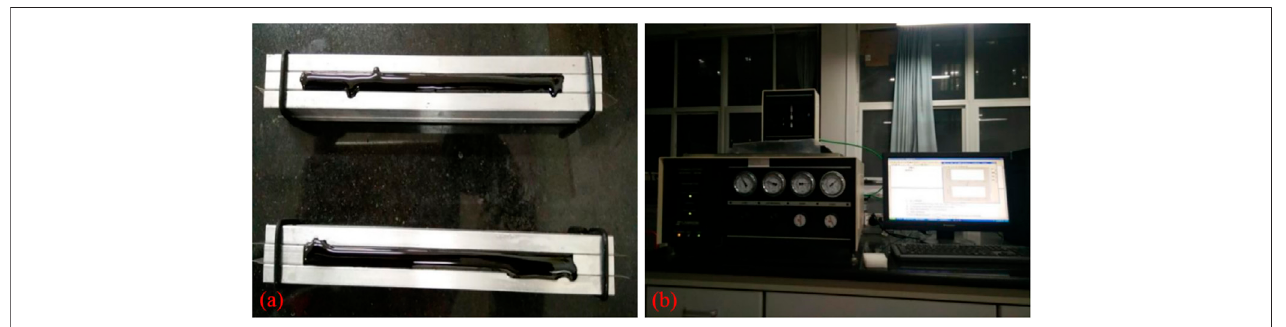
FIGURE 2 | (A) The preparation of specimens and (B) the BBR test.